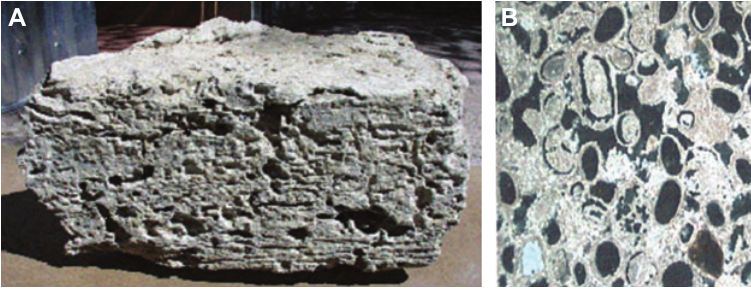
Figure 4 The Kenchreae porous stone. (A) Remains of a structural element at the Epidauros archaeological site. (B) Enlarged view of a thin section.